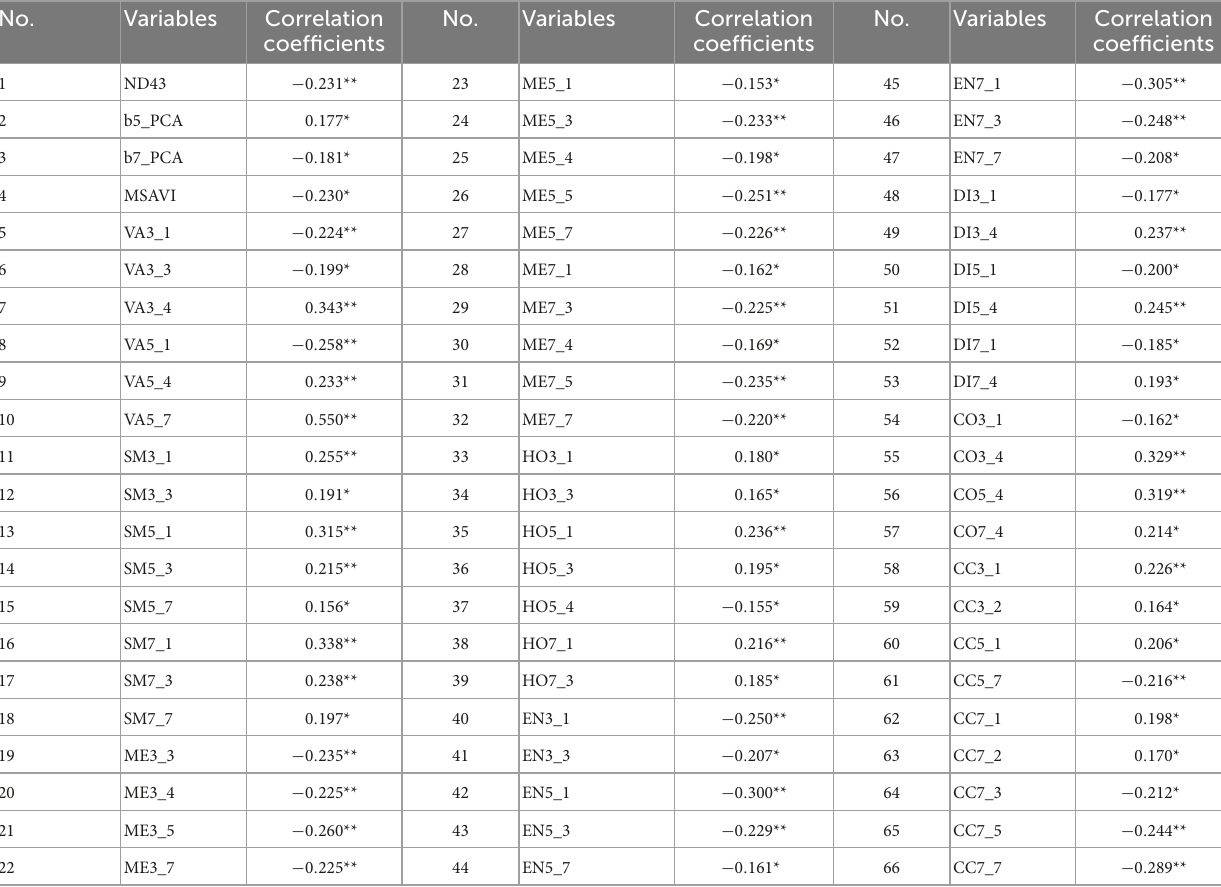
TABLE 3 Significant pearson correlation coefficients between remote sensing factors and AGB (ND43, normalized difference vegetation index using R and G bands; B5_PCA, the 5th component of PCA; B7_PCA, the 7th component of PCA; MSAVI, modified soil vegetation index, and all other variables are texture